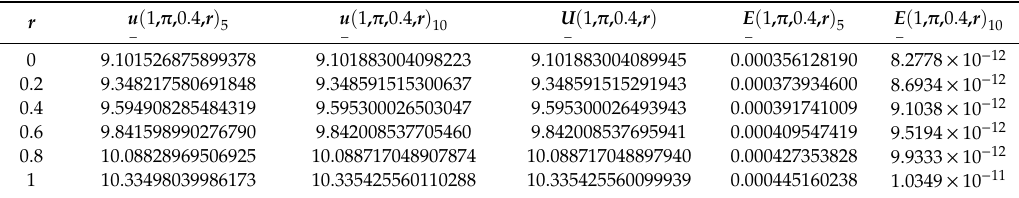
Table 9. Solution and accuracy of fifth and tenth order double parametric fuzzy HPM solutions for Equation (32) at t = π , x = 1 and b = 0.4 for all r ∈ [ 0,1 ] .